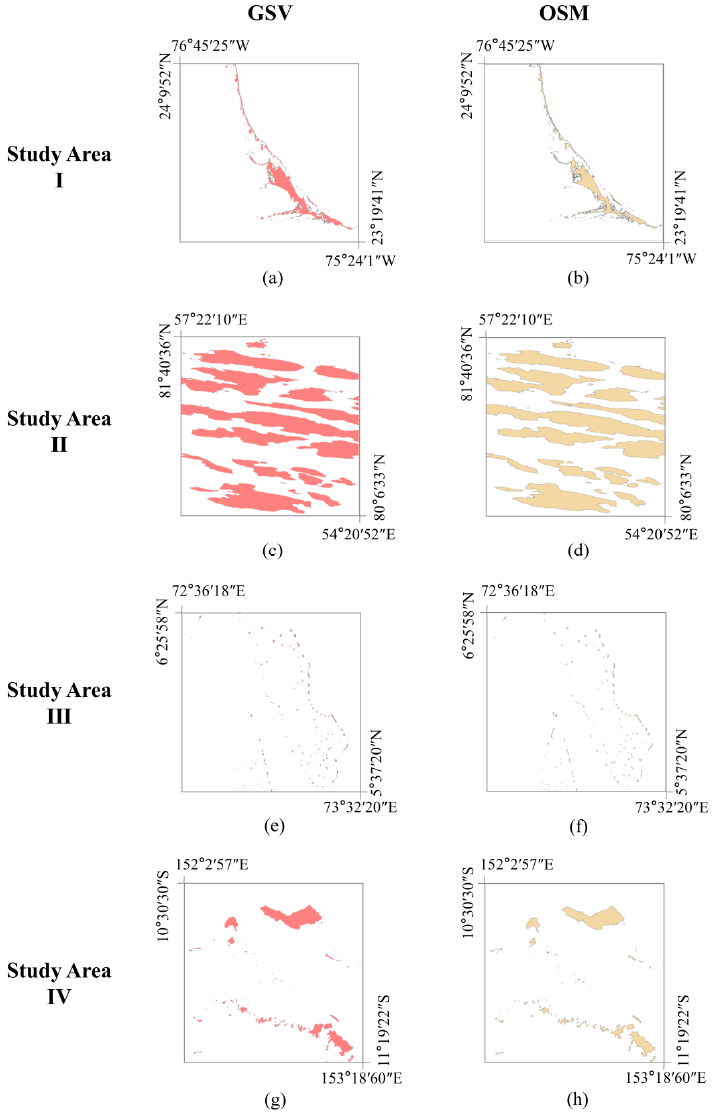
Figure 1. The GSV and OSM datasets of four study areas: I ( a , b ); II ( c , d ); III ( e , f ); and IV ( g , h ).